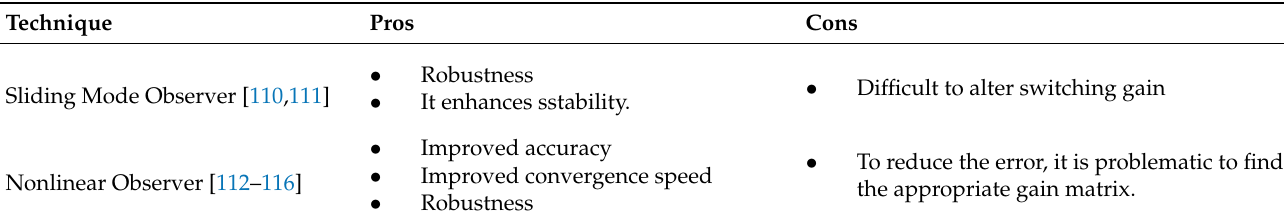
Table 8. Analysis of the different nonlinear observer SOC estimation algorithms.